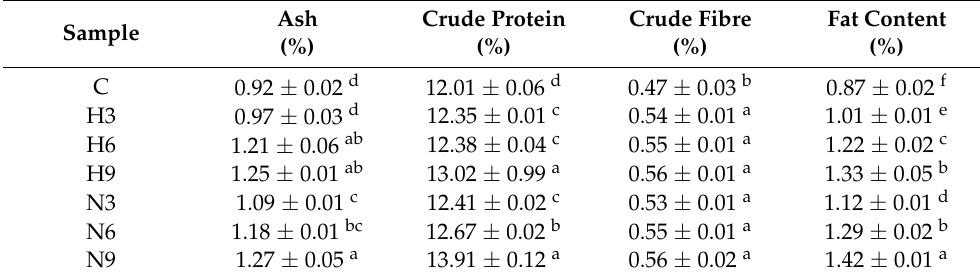
Table 1. Nutritional parameters of the breads